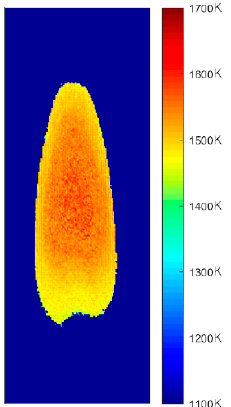
Figure 8. Flame temperature distribution after image fusion.